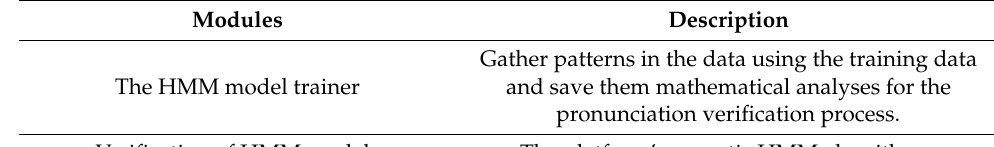
Table 1. Different modules of the Speak Correct computerized